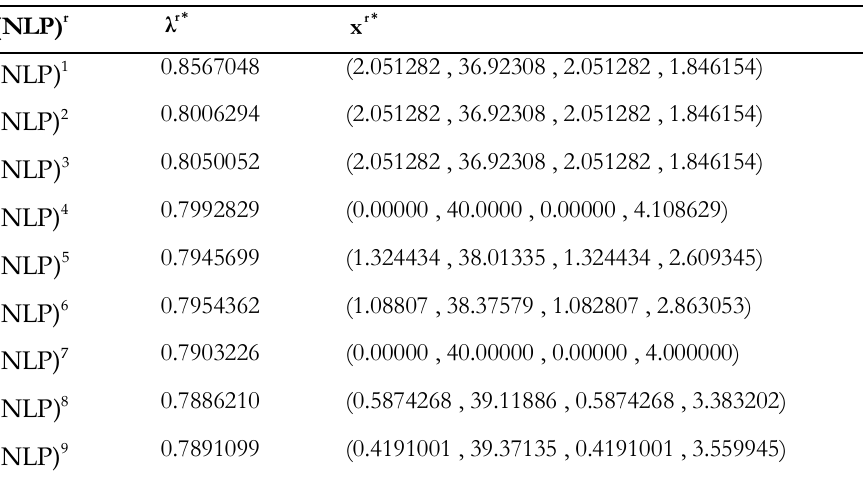
Table 3. Information for the solution of the